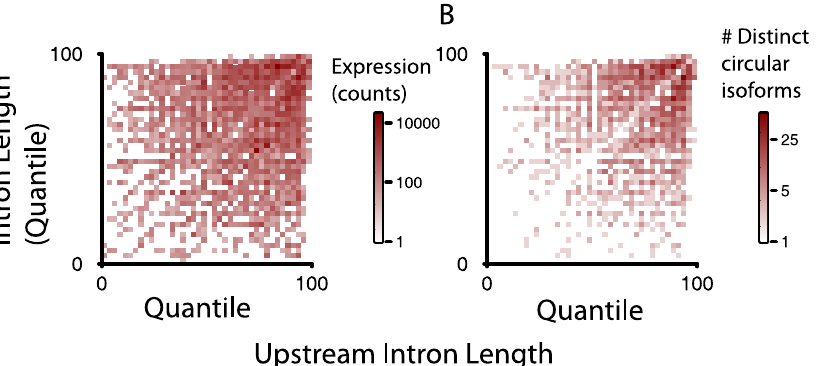
Figure 4. Intron length is enriched around exons defining circular RNA, but alone not explanatory of circular RNA expression. Intron lengths flanking circular isoforms are calculated as described in the main text. A) and B) show the genome-wide distributions of flanking intron length, normalized by their quantile rank within a gene (shortest=0; longest=100); A) weights each isoform by total reads summed over all replicates and samples; B) counts each isoform once, provided it has at least 20 distinct read